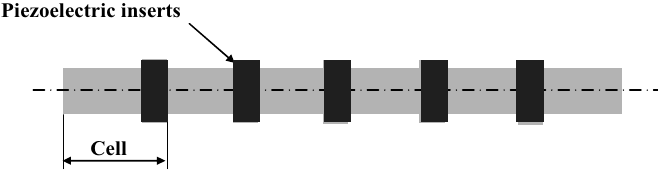
Fig. 1. Typical example of hybrid periodic rod.